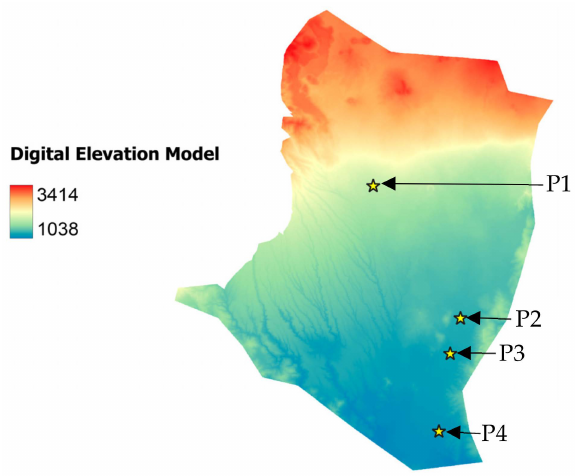
Figure 2. Elevations of the Cuernavaca aquifer.